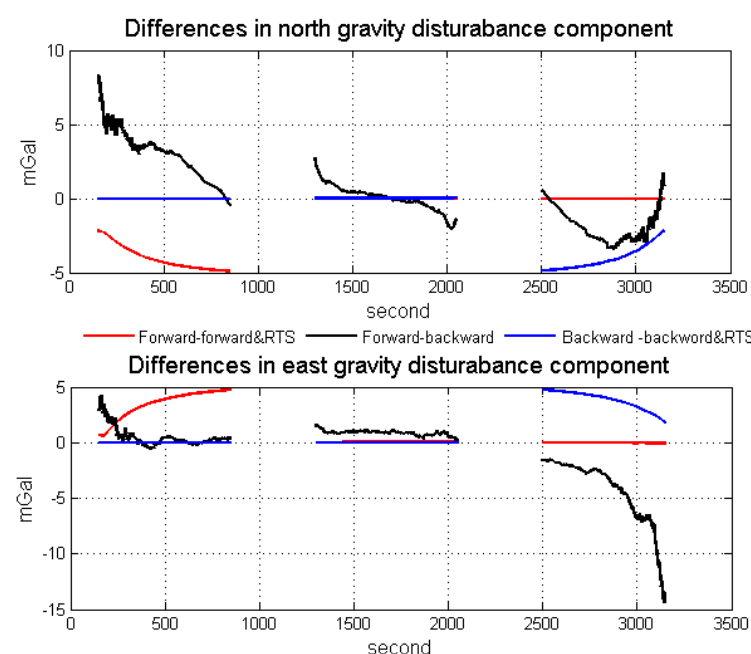
Figure 9. Differences between the forward process, the forward process using classical optimal smoothing, the backward process and the backward process using classical optimal smoothing in the simulation.